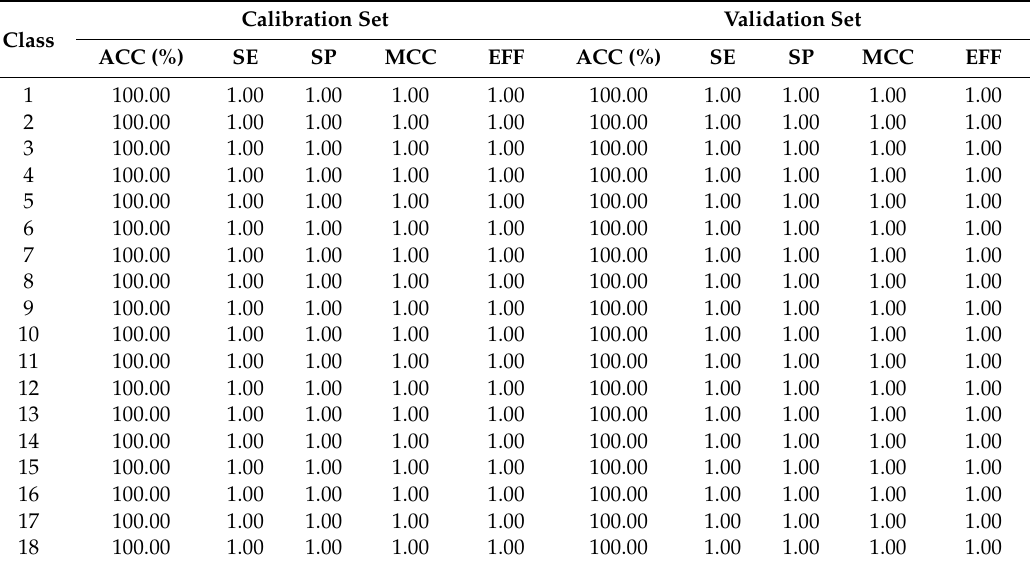
Table 4. The major parameters of SVM model based on FT-MIR full spectra